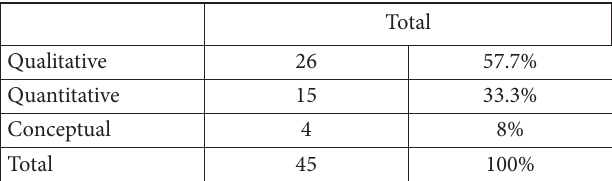
Table 2. Methodological overview of studies (source: authors, 2019)